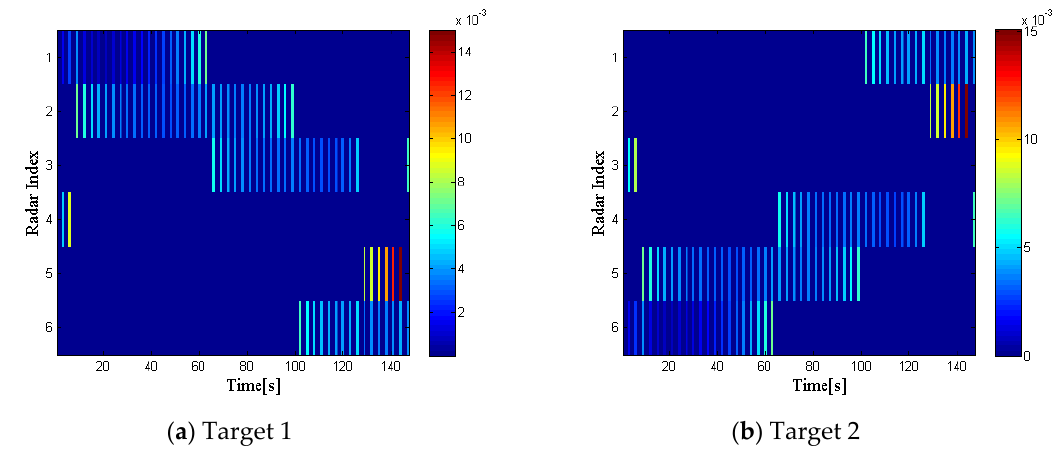
Figure 9. Radar selection and bandwidth allocation in RCS case 2.